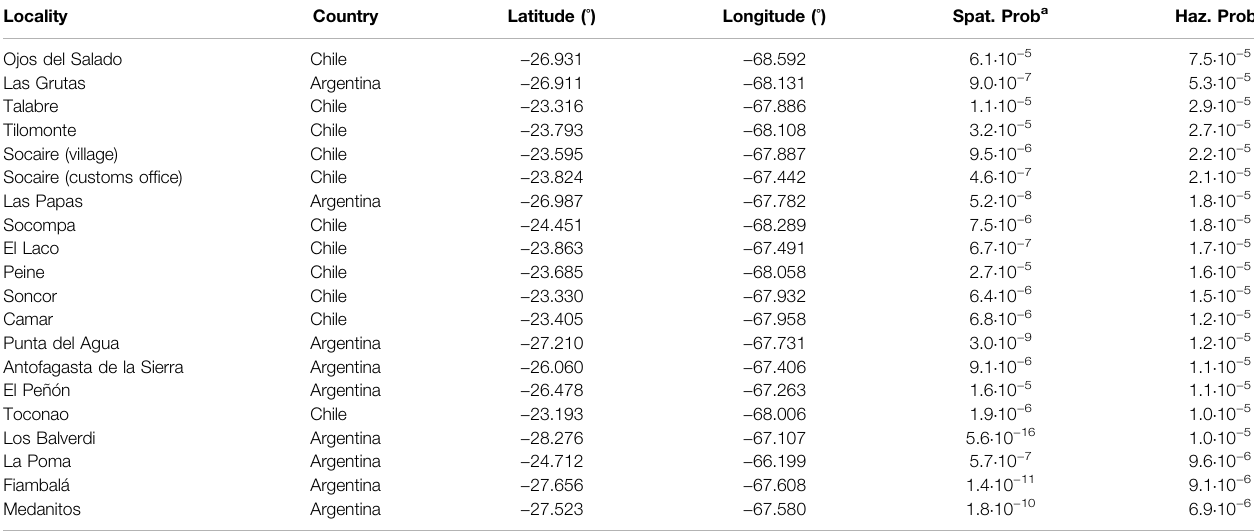
TABLE 1 | The 20 settlements most likely to be affected by any volcanic phenomenon in case an eruption occurs in the study region. For the complete list of settlements analysed, the reader is referred to Supplementary Material S6